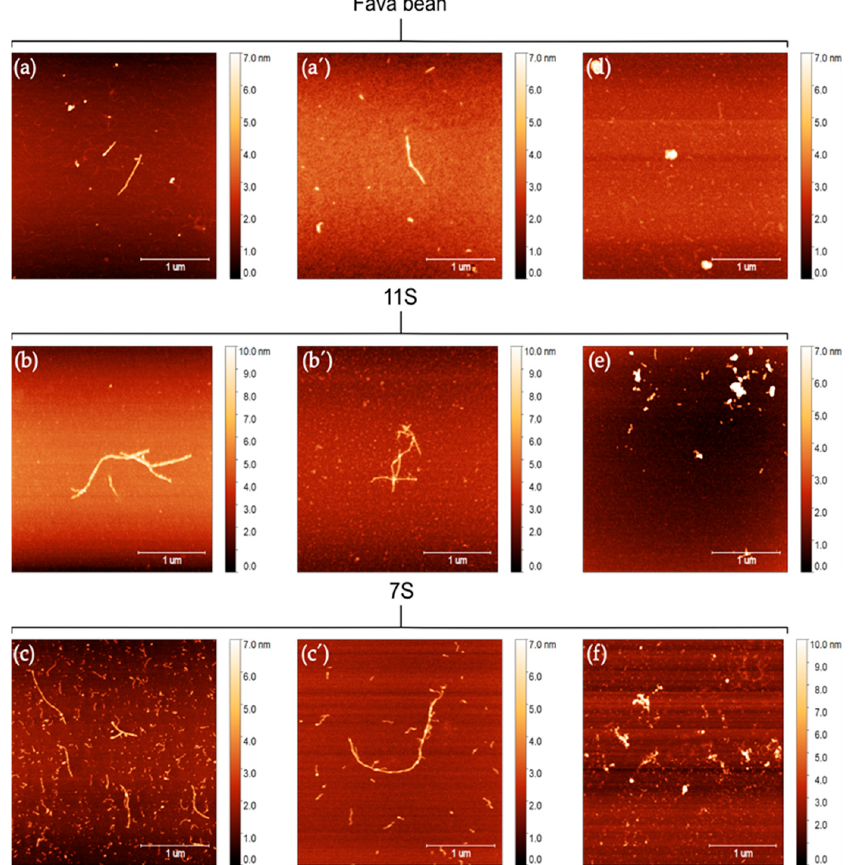
Figure 3. Atomic force microscopy images of two separate batches of fibrillated protein at pH 2 from ( a – a (cid:48) ) fava bean isolate, ( b – b (cid:48) ) fava bean globular fraction 11S, and ( c – c (cid:48) ) fava bean globular fraction 7S. Atomic force micrographs of fibrillated protein from ( d ) fava bean isolate, ( e ) 11S, and ( f ) 7S after pH adjustment to